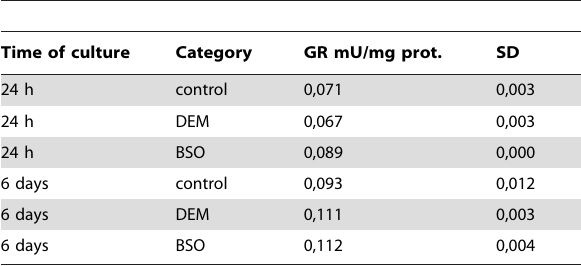
Table 2. Effect of glutathione depletion on Glutathione reductase (GR)